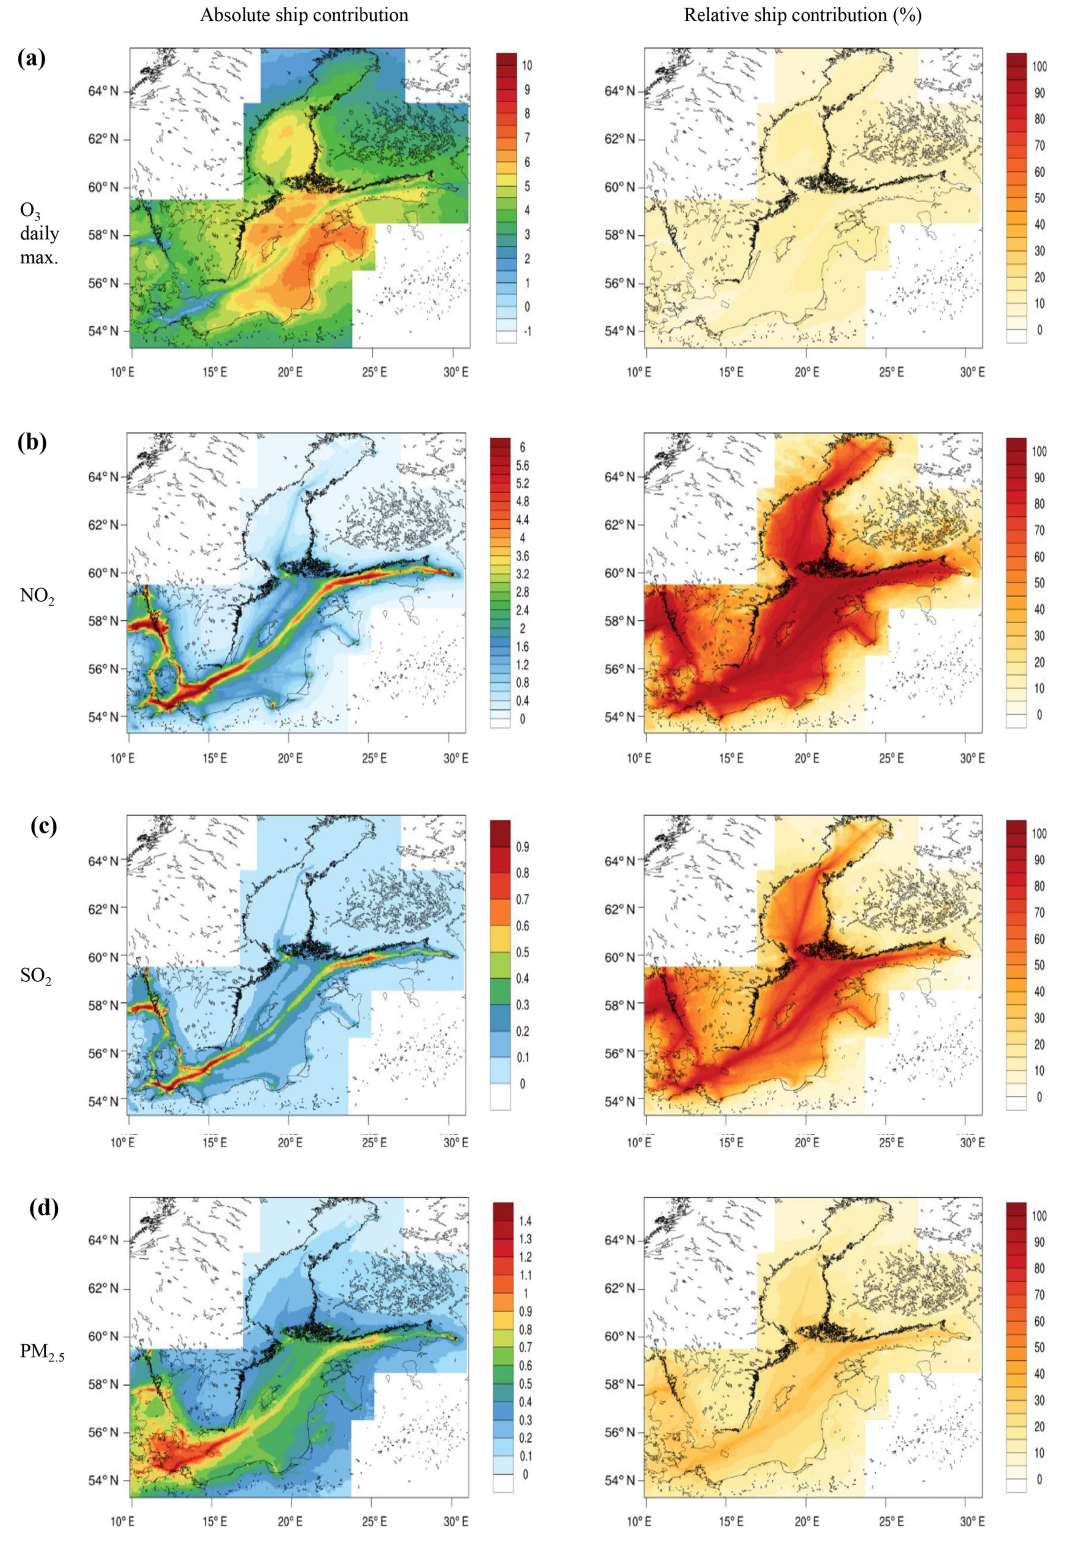
Figure 5. Present-day (2012) ship contribution in the Baltic Sea region in summer (JJA) from CMAQ model results: ship-related concen- tration (left) for gaseous pollutants (in ppbv) and for PM 2 . 5 (in µgm − 3 ), percentage ship contribution (right) for (a) daily maximum O 3 , (b) NO 2 , (c) SO 2 and (d) PM 2 . 5 . Ship-related contribution only shown for the high-resolution area. See text for